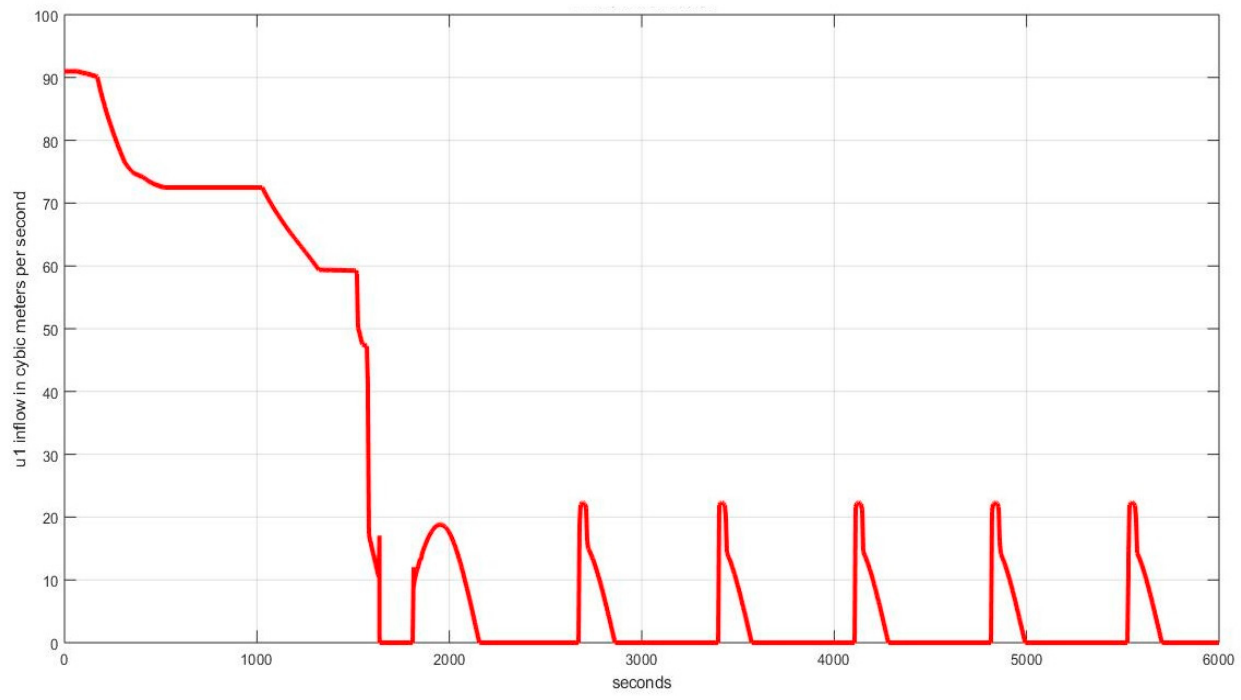
Figure 14. Traditional system (Fuzzy and Fuzzy PID) vs. Proposed system (sinusoidal disturbance, steady state).